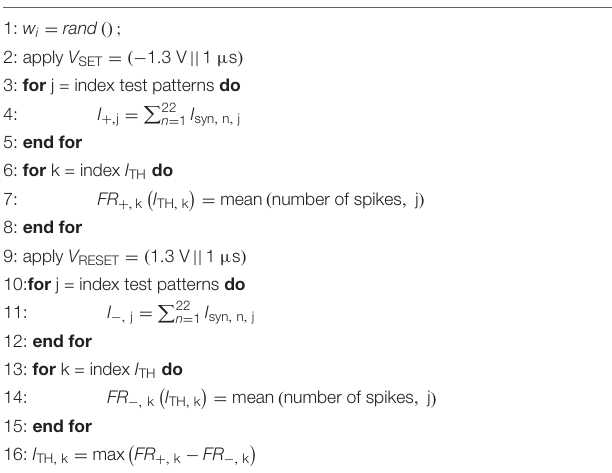
Algorithm 2 : Hyperparameter tuning algorithm.